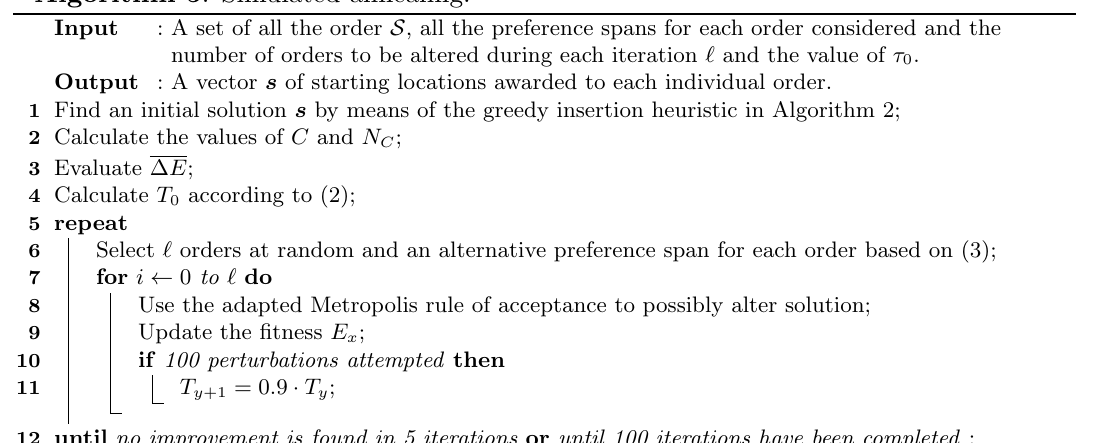
Algorithm 5 : Simulated